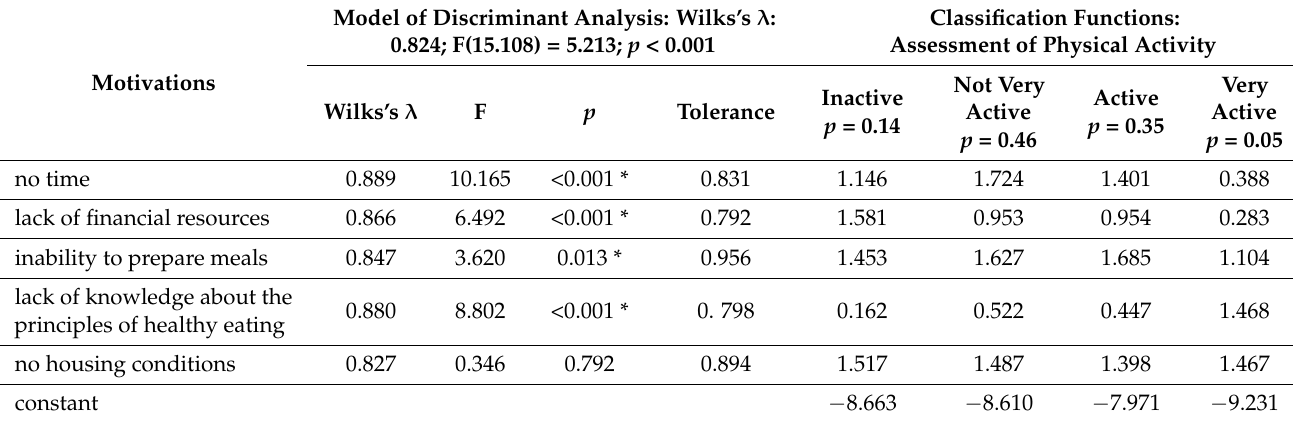
Table 9. Barriers for young Poles to employing healthy eating habits depending on the physical activity—discriminant